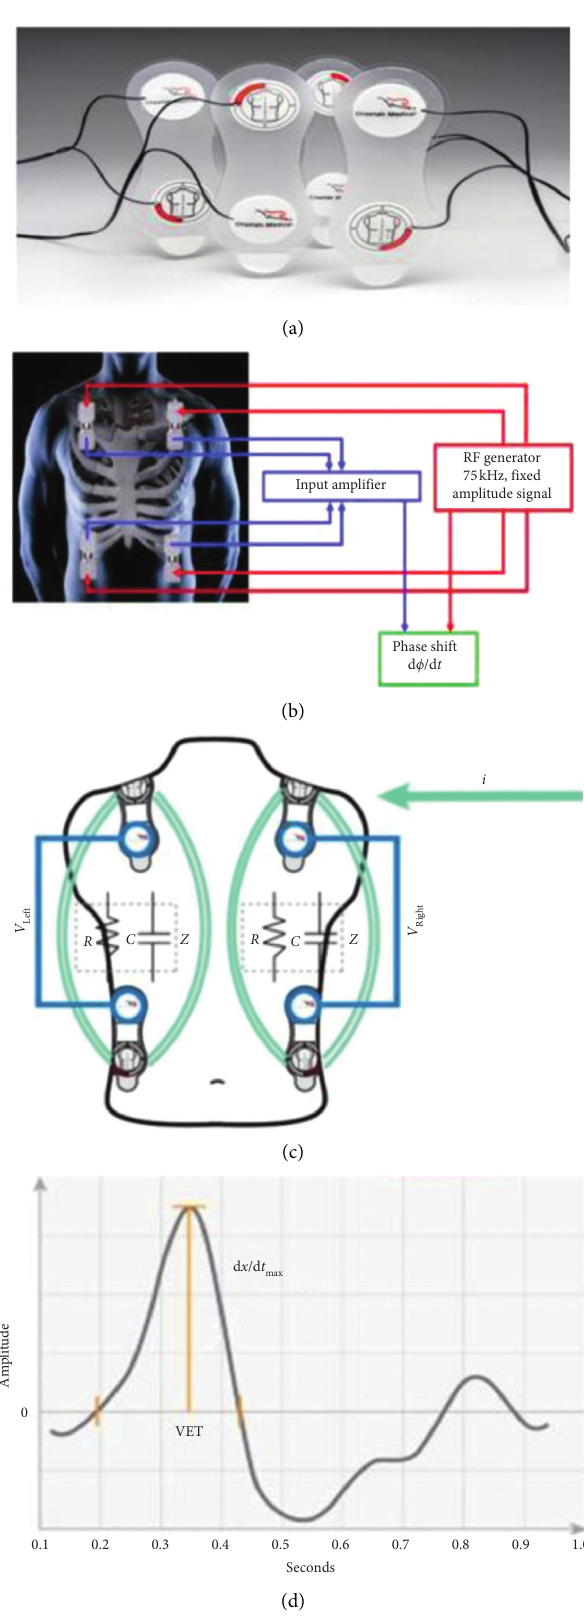
Figure 1: The NICOM system and its connection to the body. (a) Four double-electrode stickers are placed around the thorax. (b and c) A high- frequency current is passed between the 2 outer electrodes, and the resulting voltages are recorded between the 2 inner electrodes. The relative phase shift ( ɸ ) and rate of change of phase (d ɸ /d t ) between these signals are determined and used in the calculations of stroke volume (SV). RF radio frequency (d) schematic representations of aortic flow as a function of time underlying the basic principle for estimation of SV from changes in relative phase shifts (d x /d t max ) and ventricular ejection time